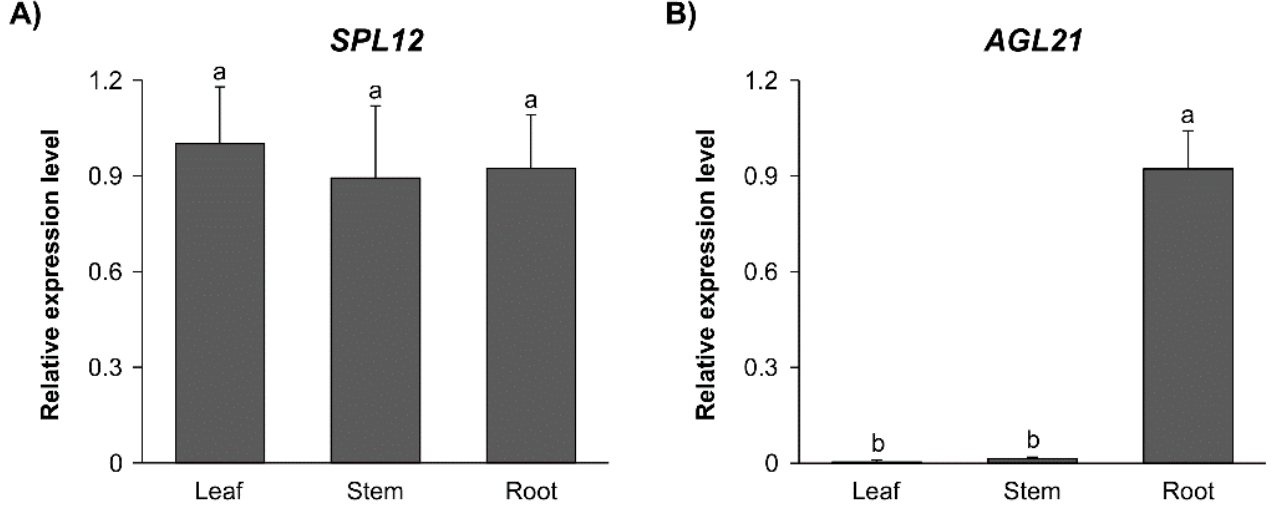
Figure 3. Tissue-specific transcript profiles of SPL12 and AGL21 . Relative transcript levels of ( A ) SPL12 , and ( B ) AGL2 1 in leaf, stem, and root of WT plants. Significant difference from ANOVA was followed by post hoc Tukey ( p < 0.05) multiple comparisons test indicated with different letters. Error bars indicate standard deviation.